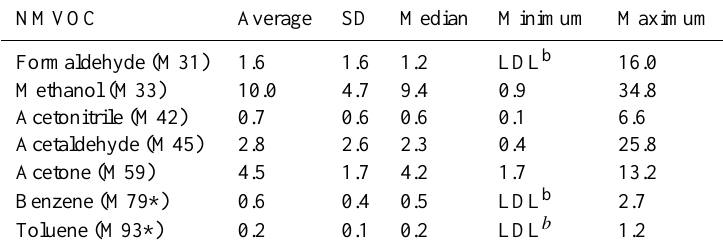
Table 4. Averaged, standard deviation (SD), median, minimum, and maximum mixing ratios (ppbv) of NMVOCs during 12–30 June 2006. a